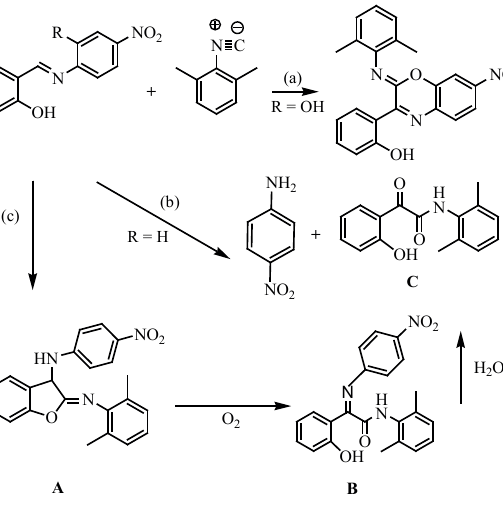
Figure 1. X-ray crystal structure of